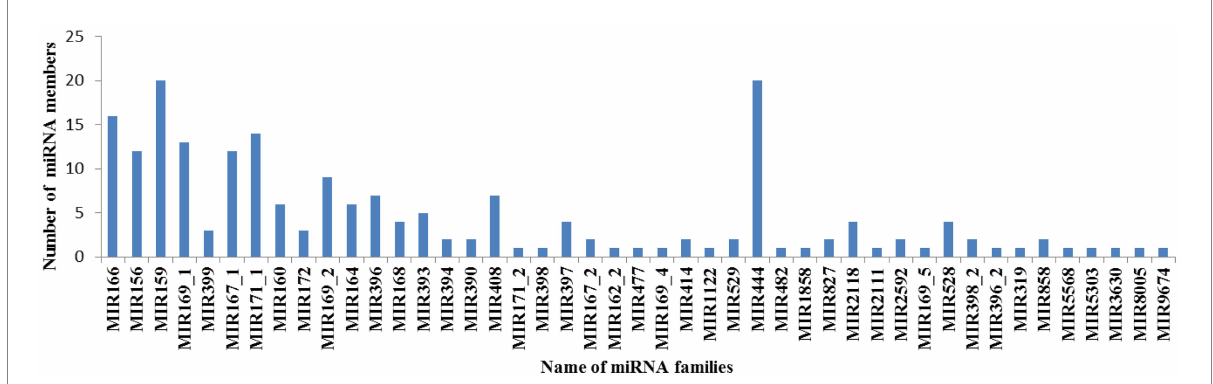
FIGURE 2 Distribution of miRNA members in each miRNA family X -axis represents the miRNA family name, while Y -axis represents the number of miRNA members in each miRNA